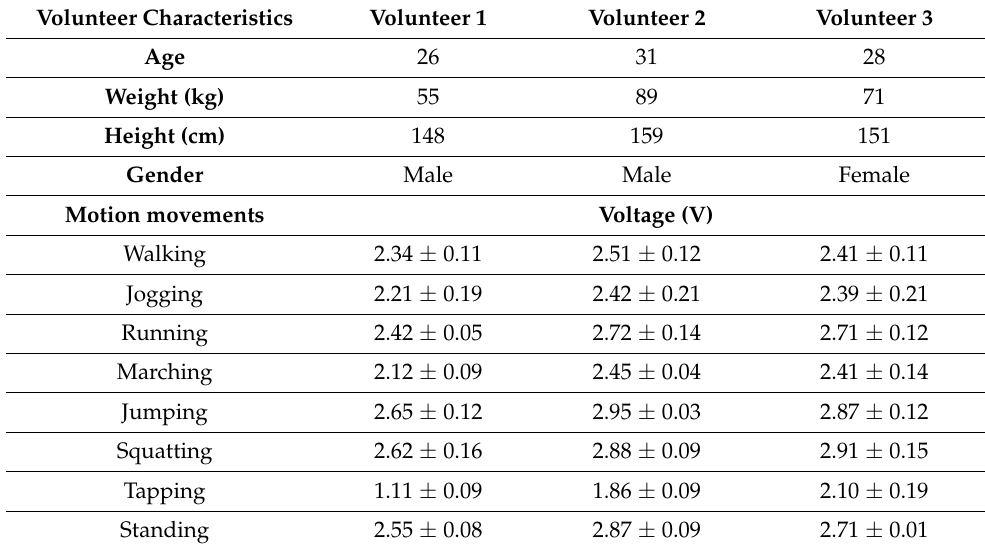
Table 3. Piezoelectric voltage recordings obtained on different volunteers for versatile body